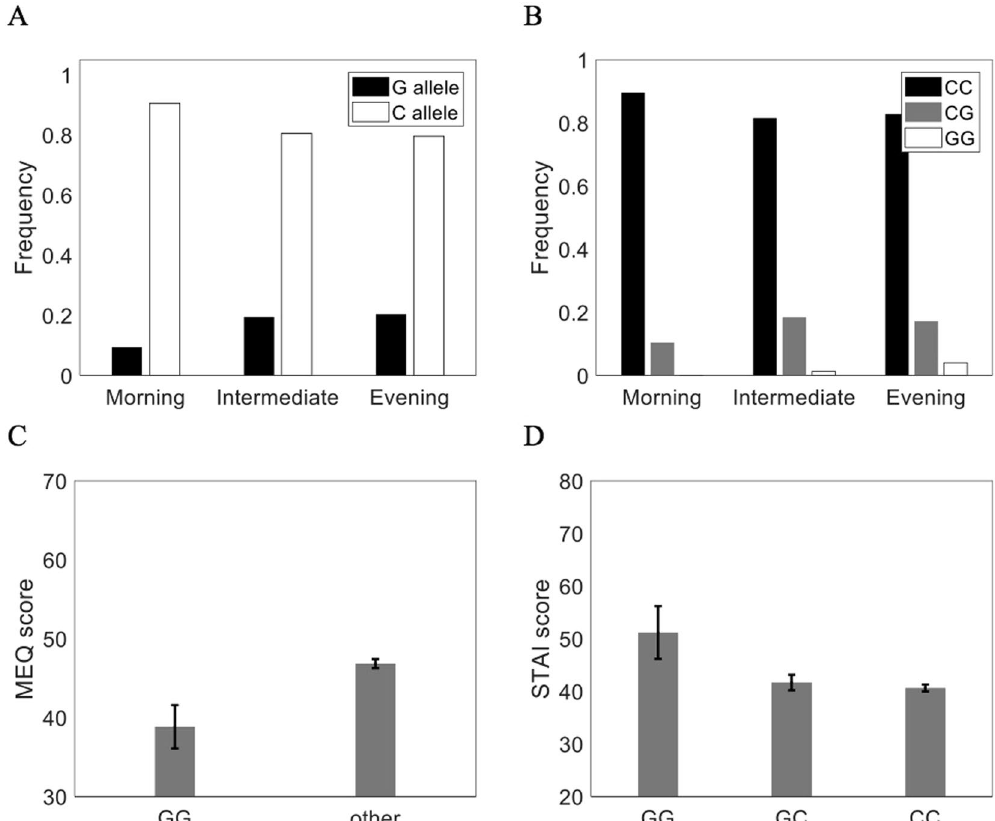
Figure 1. Associations of the PER3 single nucleotide polymorphism (SNP rs228697) with circadian chronotype and anxiety. ( A ) Frequencies of C and G alleles in morning-type (n = 48), intermediates (n = 159), and evening- type (n = 103) self-reported chronotypes. The frequency of the C allele is lower in evening-types (OR = 17.86, 95% CI = 0.99–321.61, p = 0.05). ( B ) Frequencies of the PER3 SNP genotypes in each chronotype ( χ 2 = 29.20, n = 1, p < 0.001). Individuals homozygous for the G-allele are more likely to be evening-types. ( C ) Average self- reported MEQ scores ( ± SD) are lower in GG homozygotes compared to other genotypes ( t = 7.415, df = 308, p = 0.016). ( D ) Average trait anxiety scores ( ± SD) are higher in GG homozygous individuals ( F (2,305) = 3.195, p =